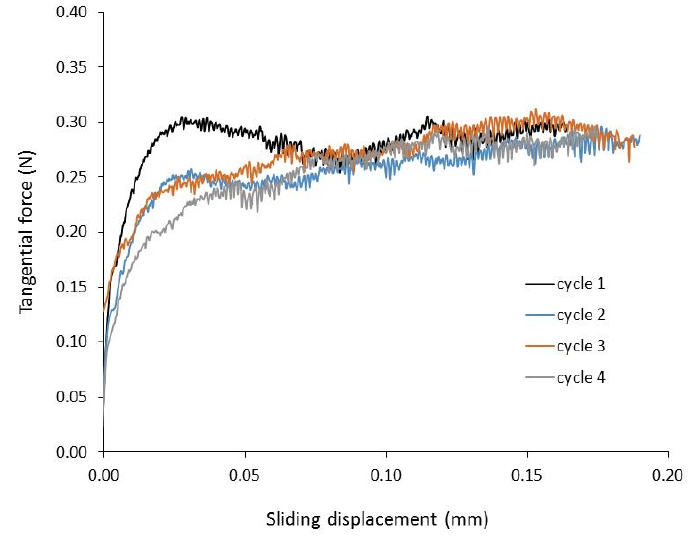
Figure 18. Tangential force–displacement plot at the contacts of CDV granules indicating the effect of the shearing cycle (tests at a normal load of 0.5 N).